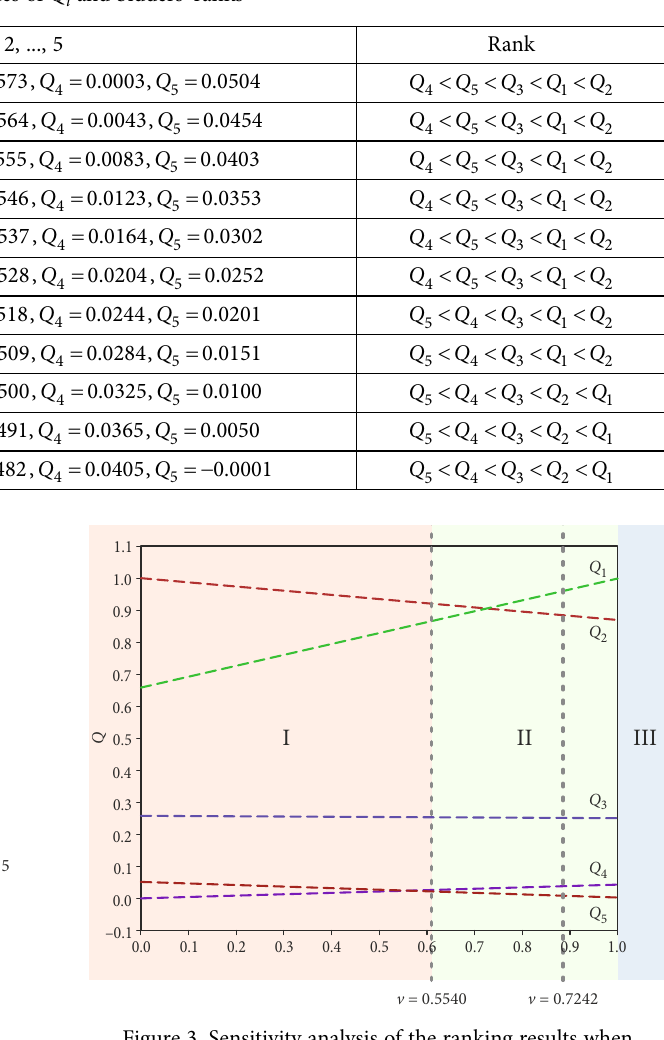
Figure 2. The different ranking results with Figure 3. Sensitivity analysis of the ranking results when weight v is taken different continuous